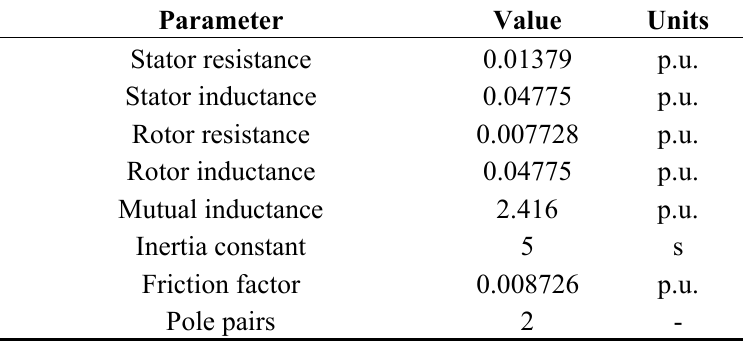
Table 1. Induction generator